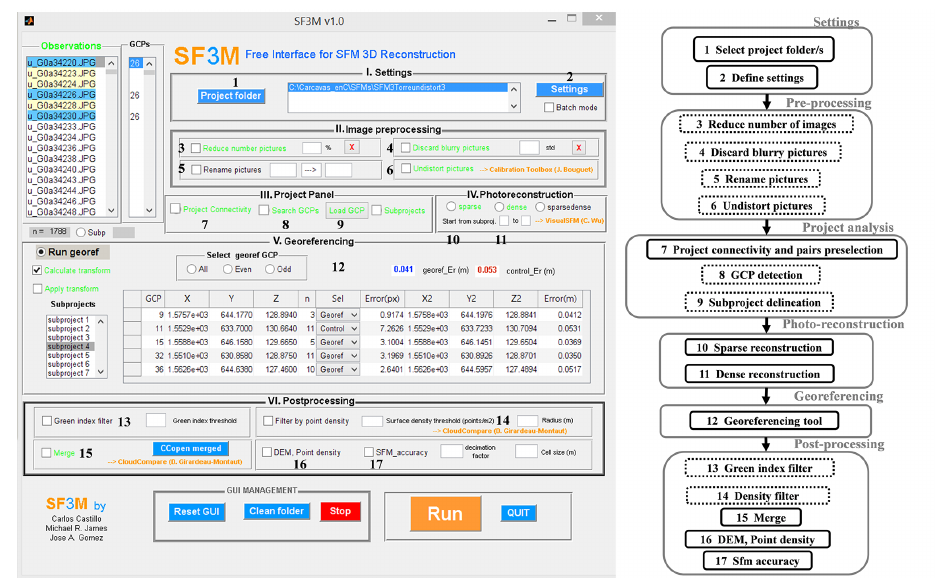
Figure 4. SF3M v1.0 workflow stages and their correspondence with command options on the SF3M main window. The dotted lines in the diagram indicate optional stages in a reconstruction